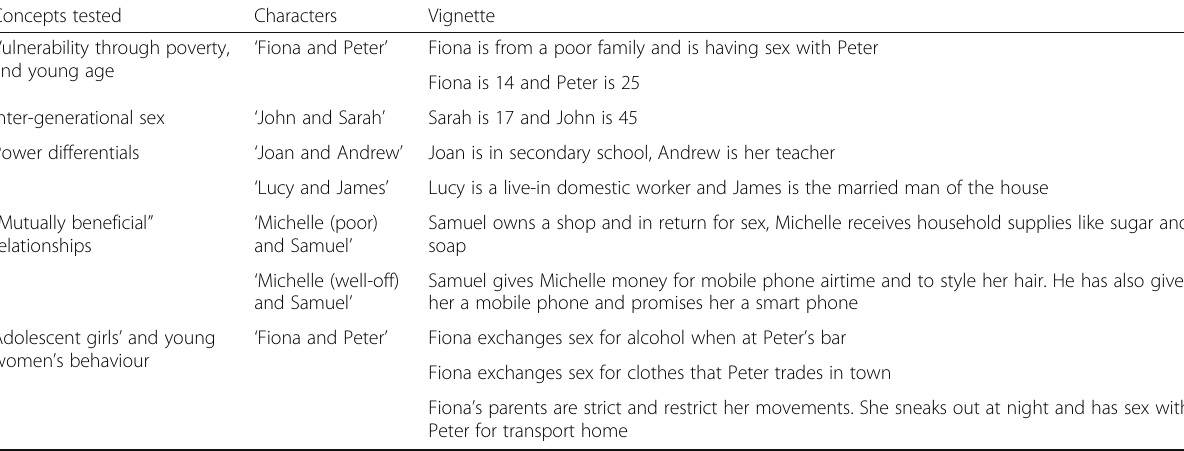
Table 2 Summary of sexual exploitation vignettes Concepts